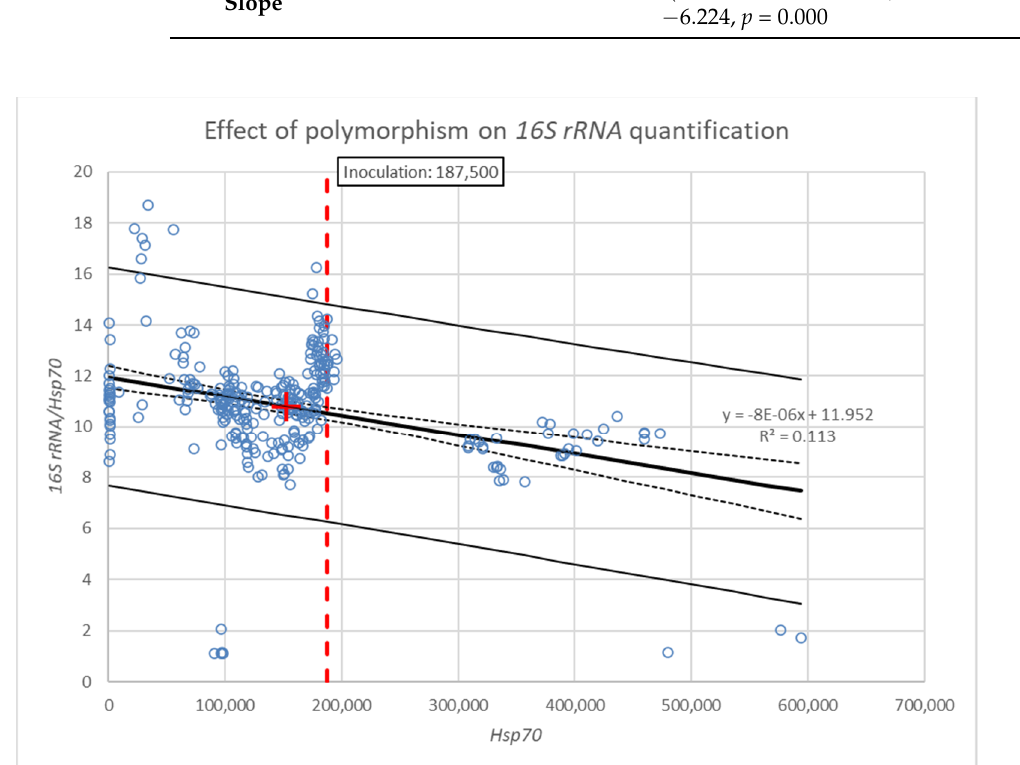
Figure 3. Linear regression analysis between the 16S rRNA/Hsp70 ratio (dependent variable) and the abundance measured with the Hsp70 method (independent variable). Legend-blue circles: experimental data, red cross: average values, red dashed line: inoculated dose, thick solid line: regression line, dashed thin lines: confidence interval of regression, solid thin lines: prediction interval.